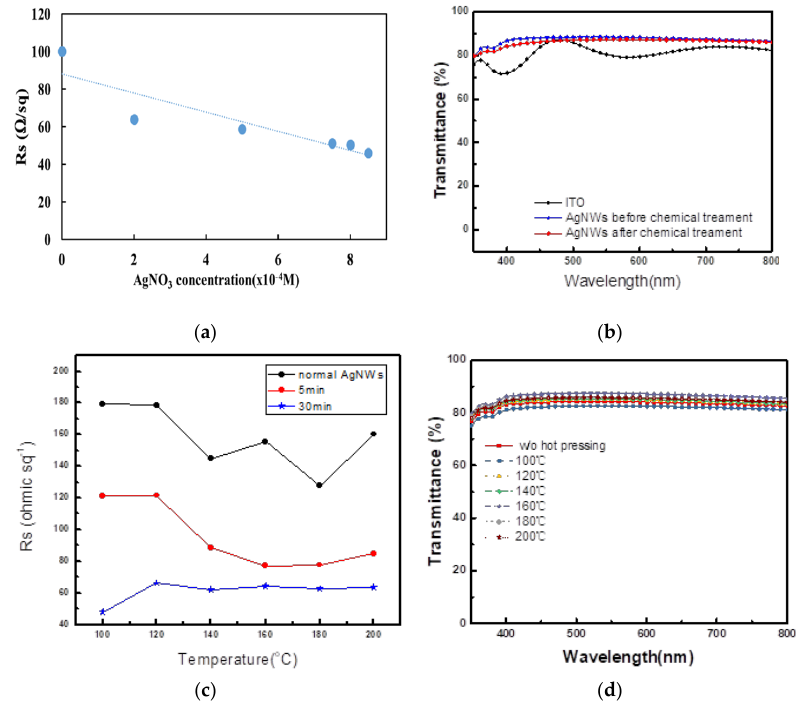
Figure 1. ( a , c ) R s values of AgNWs: ( a ) treated at different concentrations of silver nitrate; and ( c ) applied with various temperature and time periods; and ( b , d ) the UV-Vis spectra of ( b ) CT-AgNWs and ITO; ( d ) HP-AgNW electrodes. ( b ) CT-AgNWs and ITO; ( d ) HP-AgNW